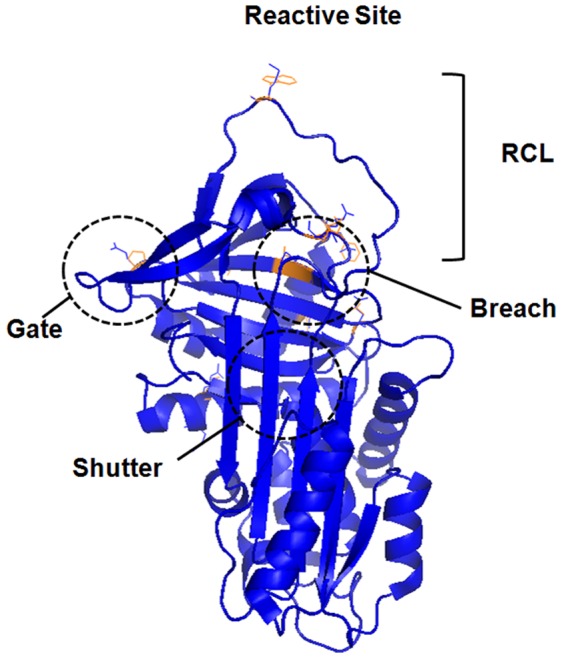
Overlapped tridimensional model of SERPINA1 and SERPINA2.The model was built using SERPINA1 structure (pdb code: 1QLP) and SERPINA2 theoretical model [17]. The image indicates the most important regions for inhibitory function – RCL, breach, shutter, and gate. Amino acids substitutions favored by selection are highlighted in orange. This figure was generated using PyMOL (PyMOL. DeLano Scientific, San Carlos) [54].